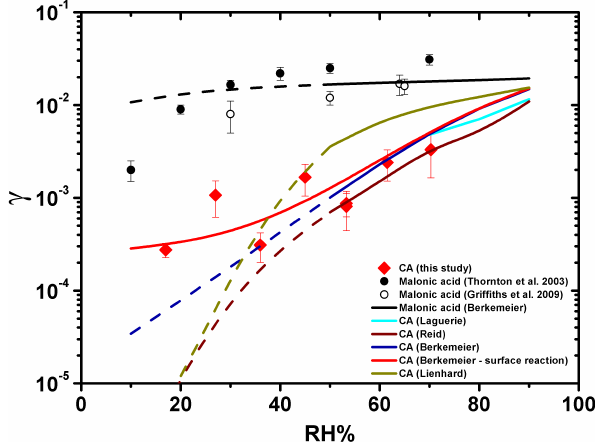
Figure 5. Parameterization of N 2 O 5 uptake on citric acid aerosol according to Eq. (4) (lines) based on diffusivities estimated by the four parameterization methods: teal: Laguerie; dark red: Reid; green: Lienhard; blue: Berkemeier. Dashed lines indicate the RH range where the Stokes–Einstein relation (Eq. 7) is not strictly ap- plicable. The red line represents the extended parameterization in- cluding a surface reaction term (Eq. 8), based on the Berkemeier H 2 O diffusivity estimates. The black line represents the parame- terization for malonic acid using the same kinetic parameters and diffusivity data estimated using the Berkemeier method for malonic acid; red diamonds: uptake coefficients measured in this study; solid circles: uptake coefficients for malonic acid according to Thornton et al. (2003); open circles: uptake coefficients for malonic acid ac- cording to Griffiths et al.